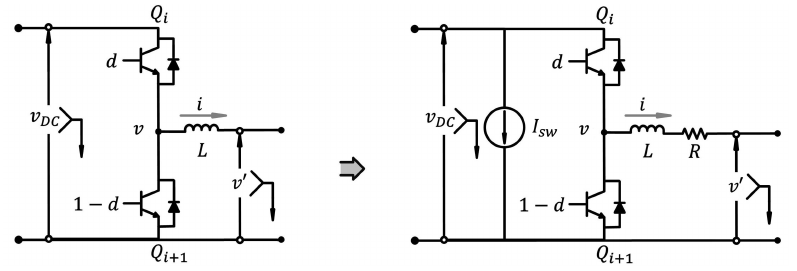
Figure 5. Conduction and switching losses of a non-ideal IGBT